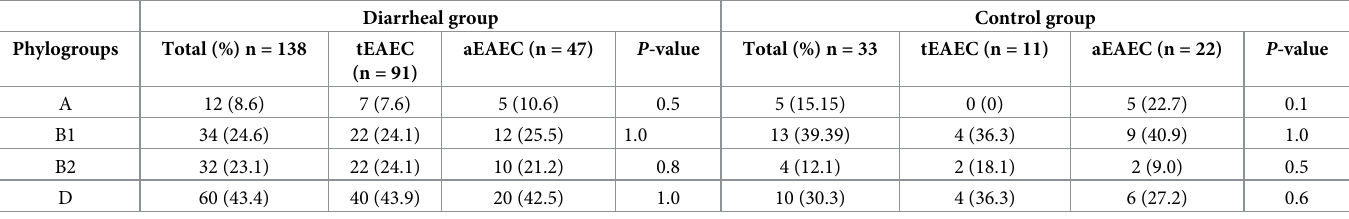
Table 9. Phylogenetic distribution of tEAEC and aEAEC in the control group.